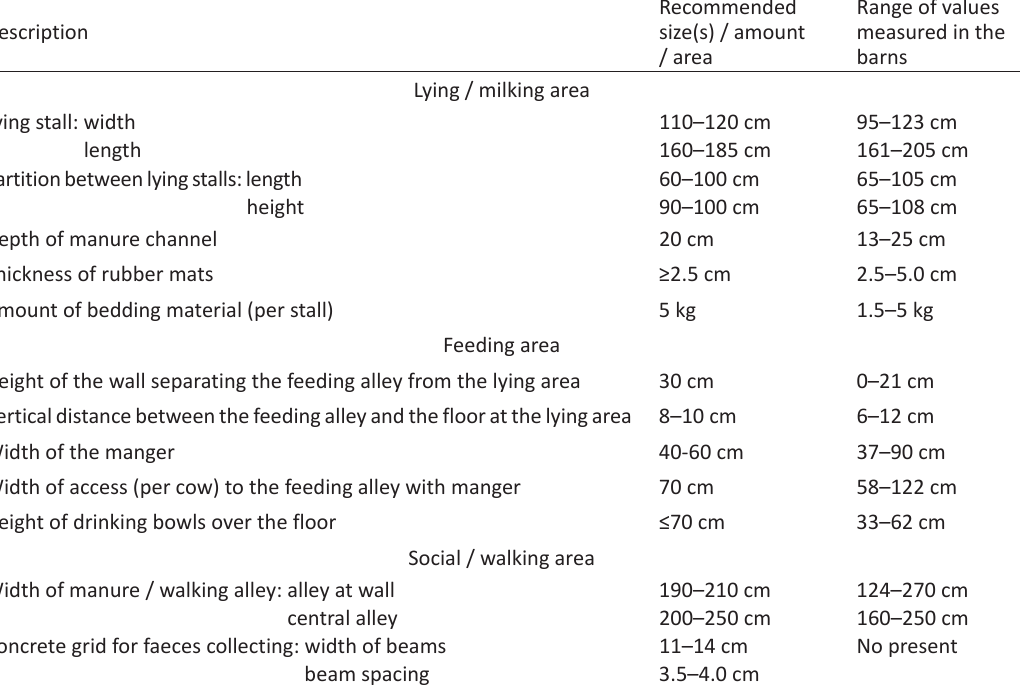
Table 1. Parameters measured in tie-stall barns in different zones (based on the range of values measured in individual barns) vs. recommended parameters (reference values) in Poland